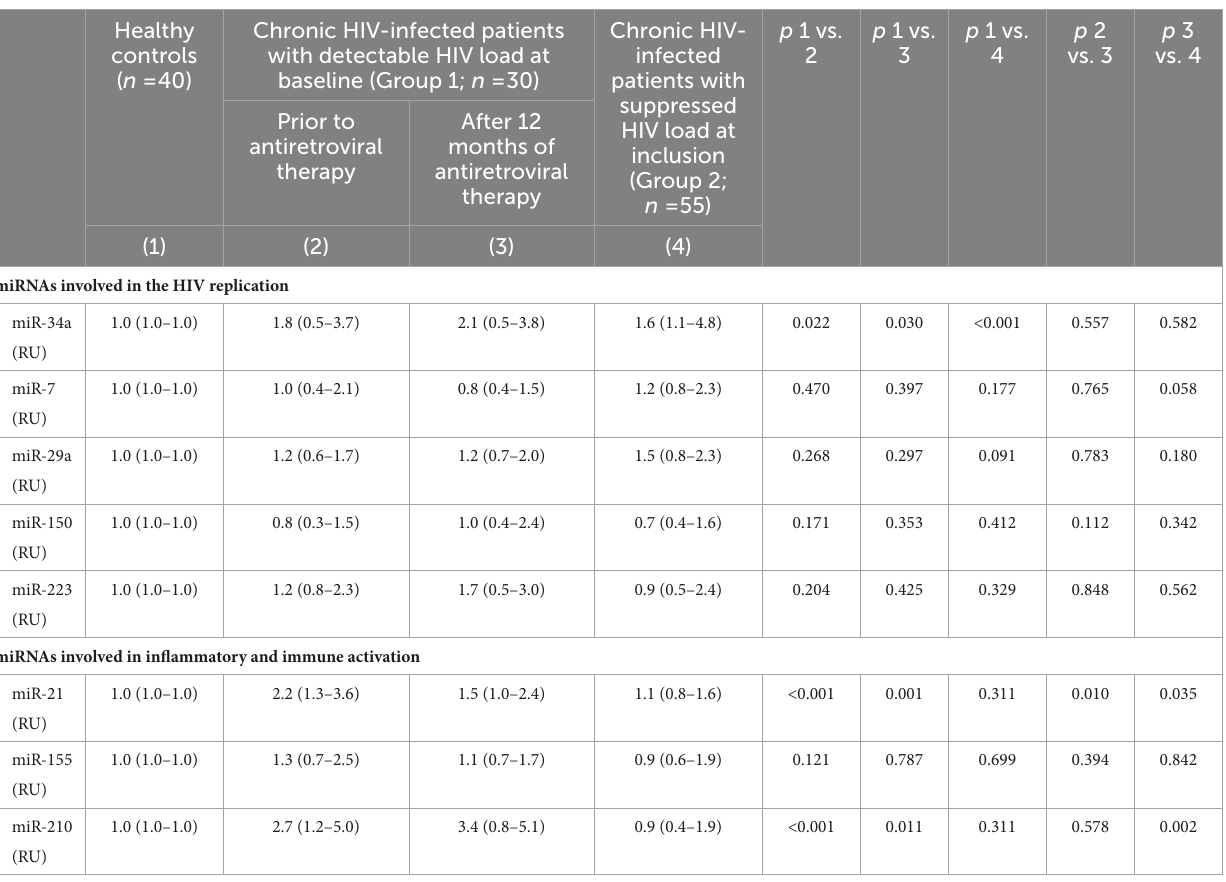
TABLE 3 Quantification of the miRNAs involved in the inhibition or facilitation of HIV infection, and of modulation of inflammation and immune activation, in healthy controls and patients with HIV infection, untreated at baseline, analyzed at inclusion and after 12 months of antiretroviral therapy, and of chronically treated HIV patients with undetectable HIV load at